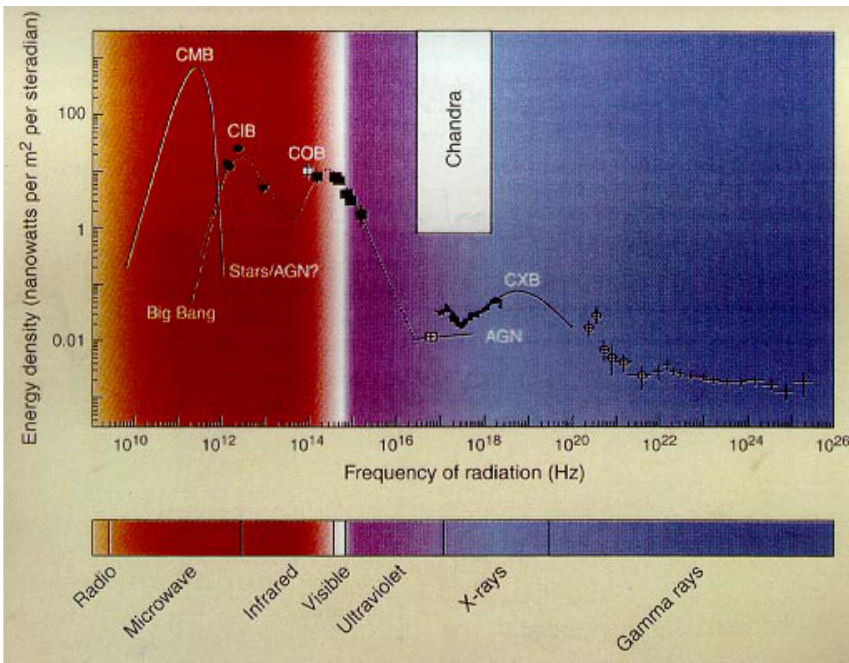
Fig. 1. Total energy density of the